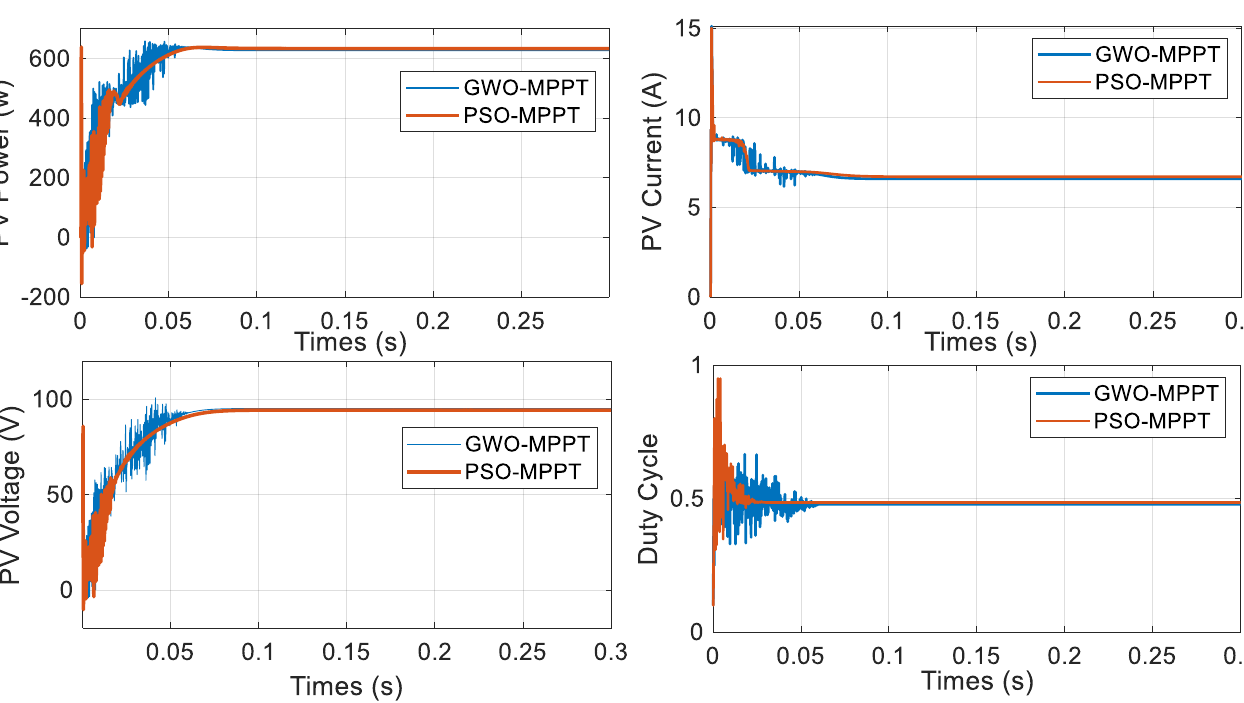
Figure 12. PV characteristics under partial shading: (500 W/m 2 , 800 W/m 2 , 1000 W/m 2 , 1000 W/m 2 ).